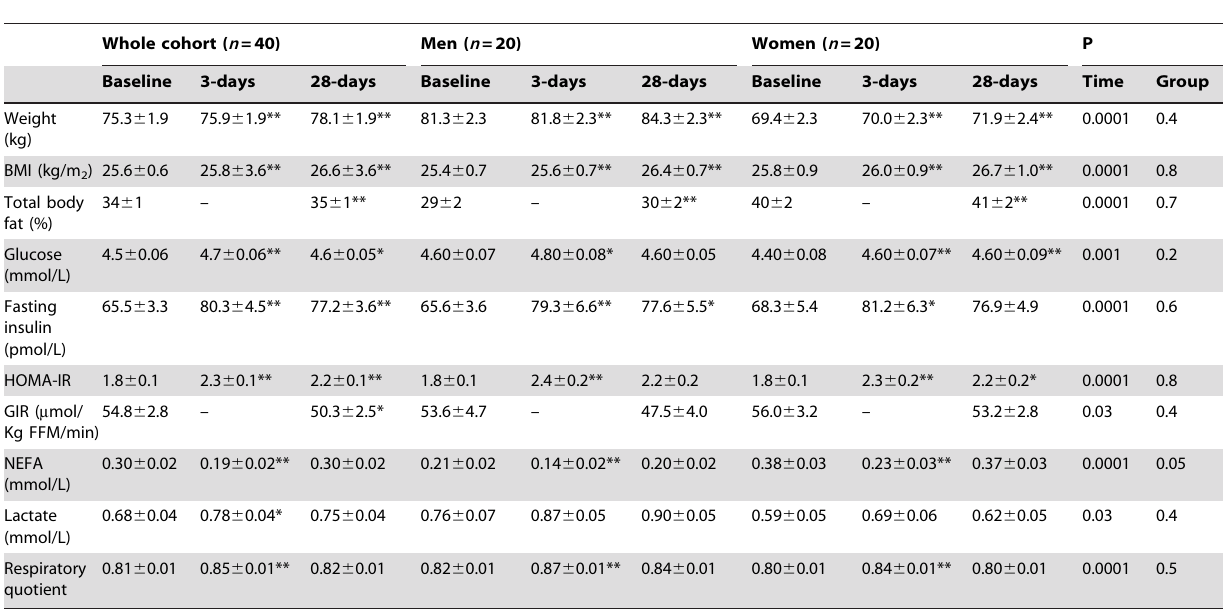
Data presented as mean 6 SEM for the whole cohort ( n =40) and for men ( n =20) and women ( n =20). Significance of the repeated measure ANOVA with time and between groups is given. Difference from baseline (by paired t-test). * P , 0.05,